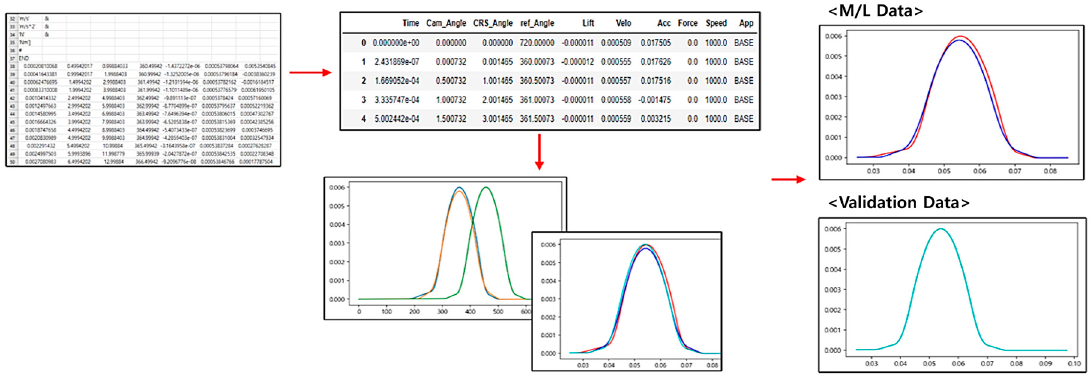
Figure 10. The preprocessing process for the diesel engine valve train data.